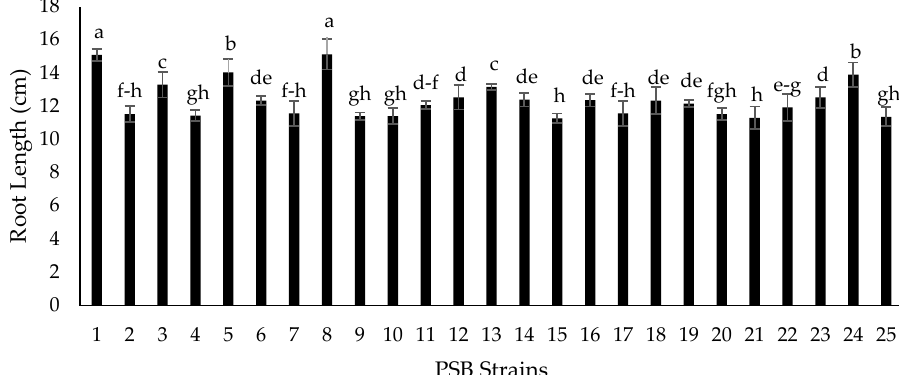
Figure 6. E ff ect of PSB strains on chickpea root length (cm). Strains (1–24) are phosphate solubilizers (RP-01 to RP-24) while 25 is the control treatment. The bars indicate standard error ( ± SE) of the mean ( n = 3). Means followed by the same letter within the bars are not significantly di ff erent at p = 0.05.